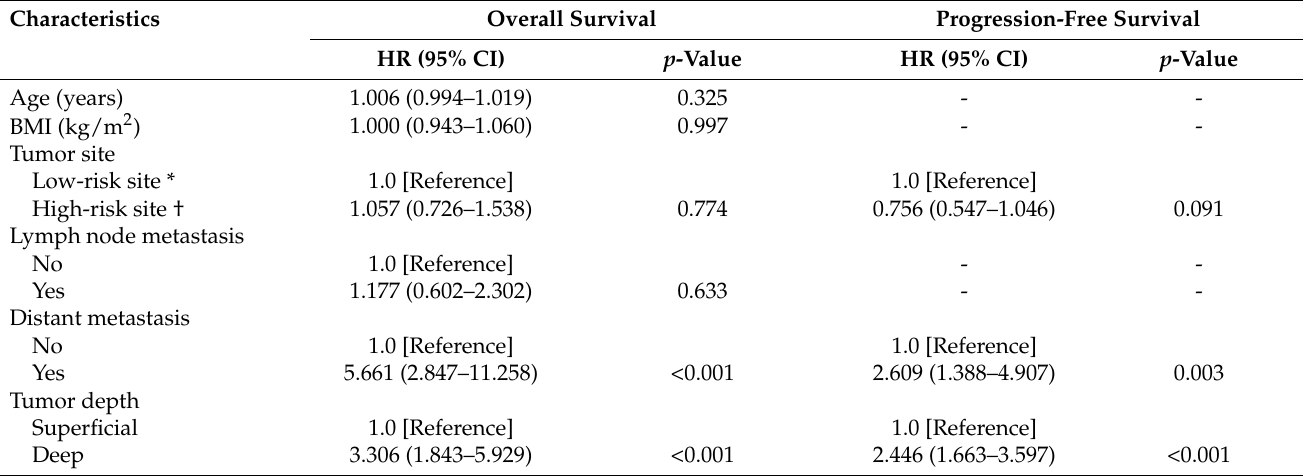
Table 3. Multivariate Cox regression analysis of factors associated with overall survival and progression-free